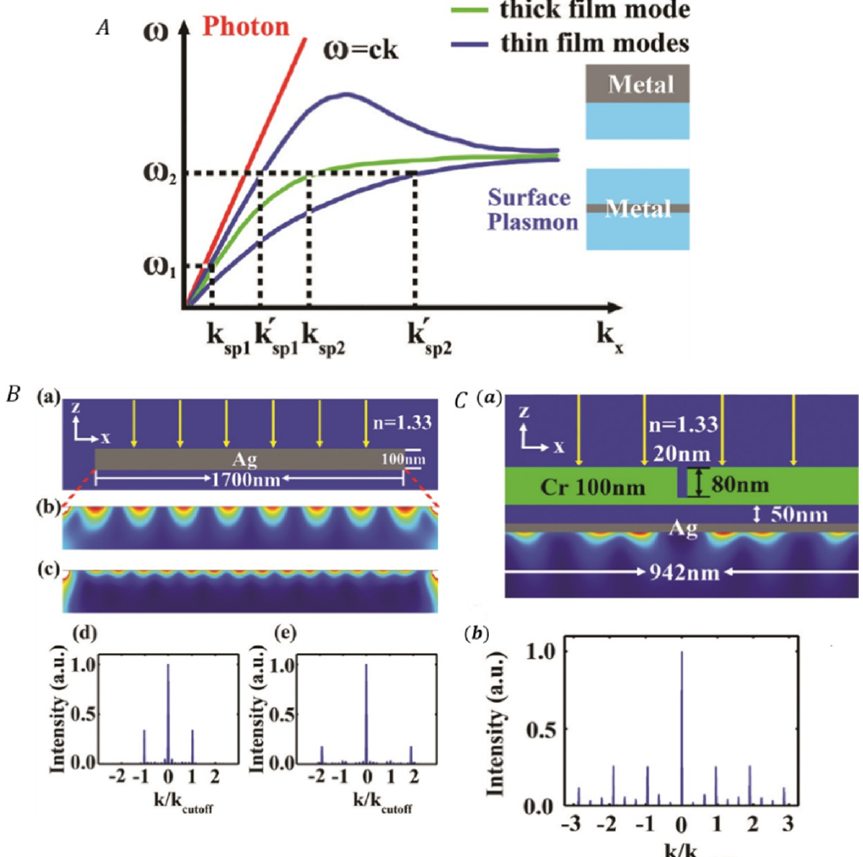
Figure 12. ( A ) Dispersion of SPs on different materials [128]. ( B ) Realization of SP interference pattern at a thick film/dielectric interface [126]. ( a ) Material parameters. ( b , c ) SPs excited by 563 and 390 nm light, respectively. ( d , e ) Fourier transforms corresponding to ( b , c ), respectively. ( C ) Realization of SP at a thick film/dielectric interface [126]. ( a ) Material parameters and SP interference pattern. ( b ) Fourier transform corresponding to SP interference in ( a ). Copyright 2010 Nano